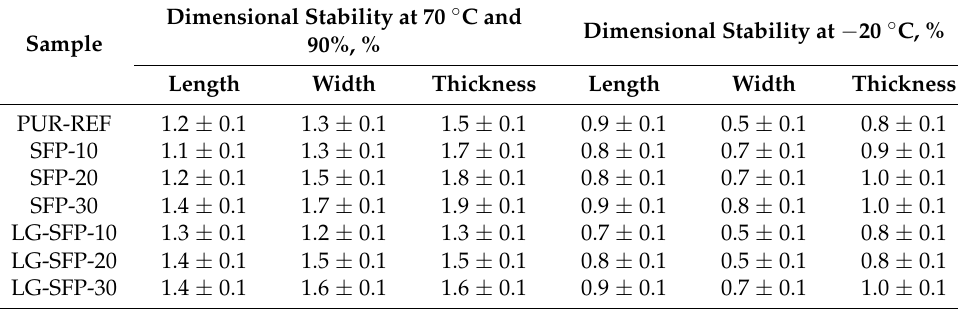
Table 3. Dimensional stability of PUR-REF, SFP, and LG-SFP modified PUR foams.